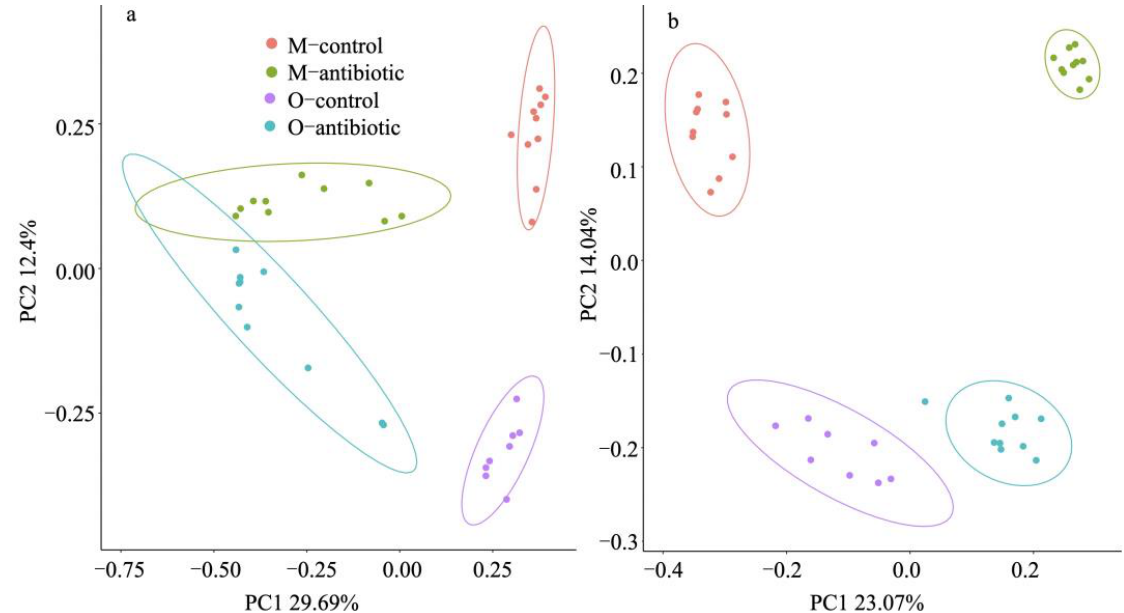
Figure 1. Comparison of the α -diversity indices (Chao 1, the number of species, Shannon, Simpson and Faith’s PD) of mothers and offspring treated with oral antibiotics. M-control and M-antibiotic stand for control mothers and antibiotics-treated mothers, respectively, while O-control and O-antibiotic represent offspring born to control and antibiotics-treated mothers, respectively. An ANOVA with Tukey’s test for multiple testing was used to obtain multiple testing of p values. Statistical significance: *, p < 0.05; **, p < 0.01; ***, p < 0.001; ****, p < 0.0001.